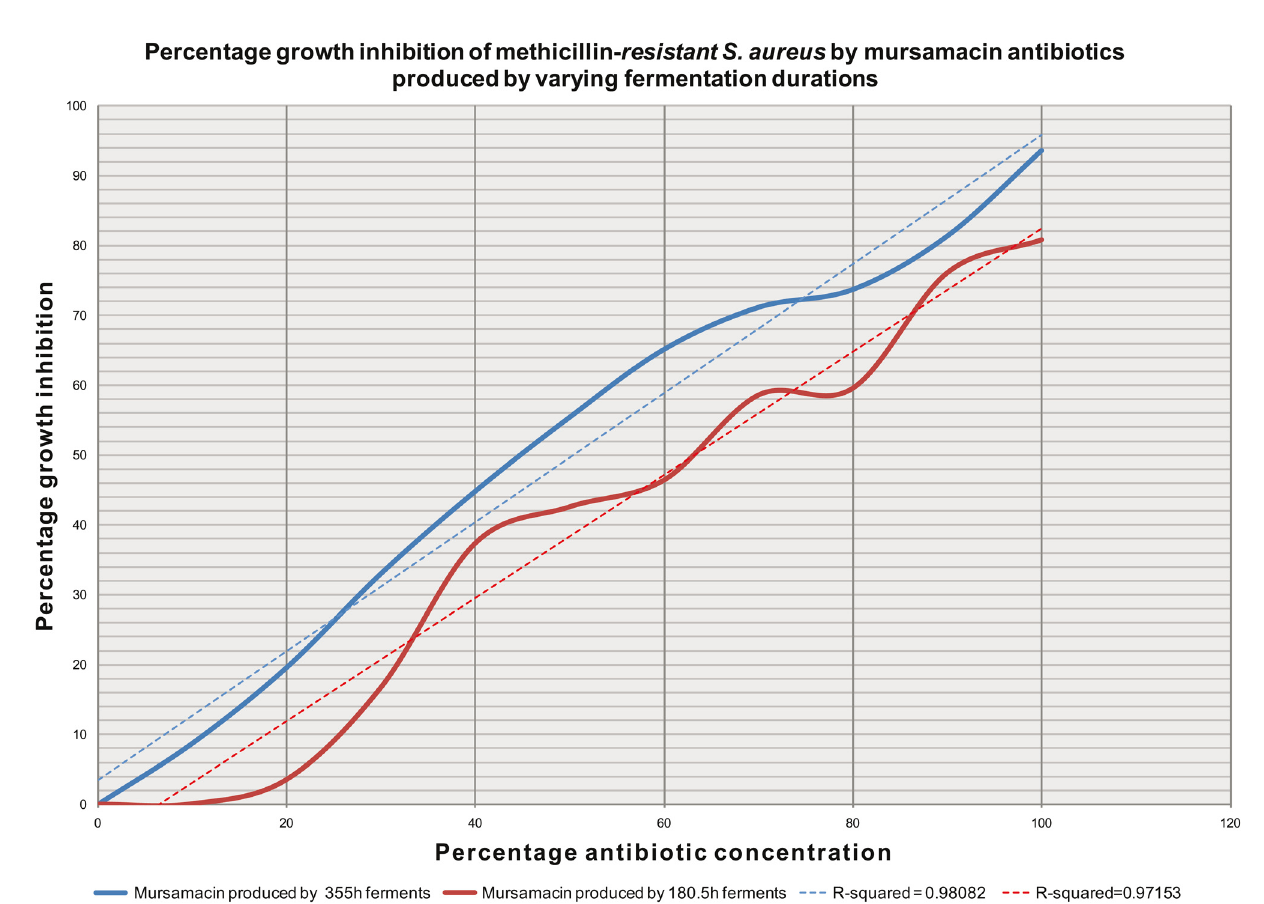
Figure 3. Growth inhibition of methicillin-resistant S. aureus by heat stable fractions of mursamacin antibiotics produced by varying fermentation durations. The longer fermentation duration (355 h) produced antibiotics that were generally more inhibitory to methicillin- resistant S. aureus. Dotted line graphs represent linear equations derived from the raw inhibition values. The high R-squared values demonstrate that the concentration of the antibiotic was predominantly responsible (97–98%) for the level of percentage growth